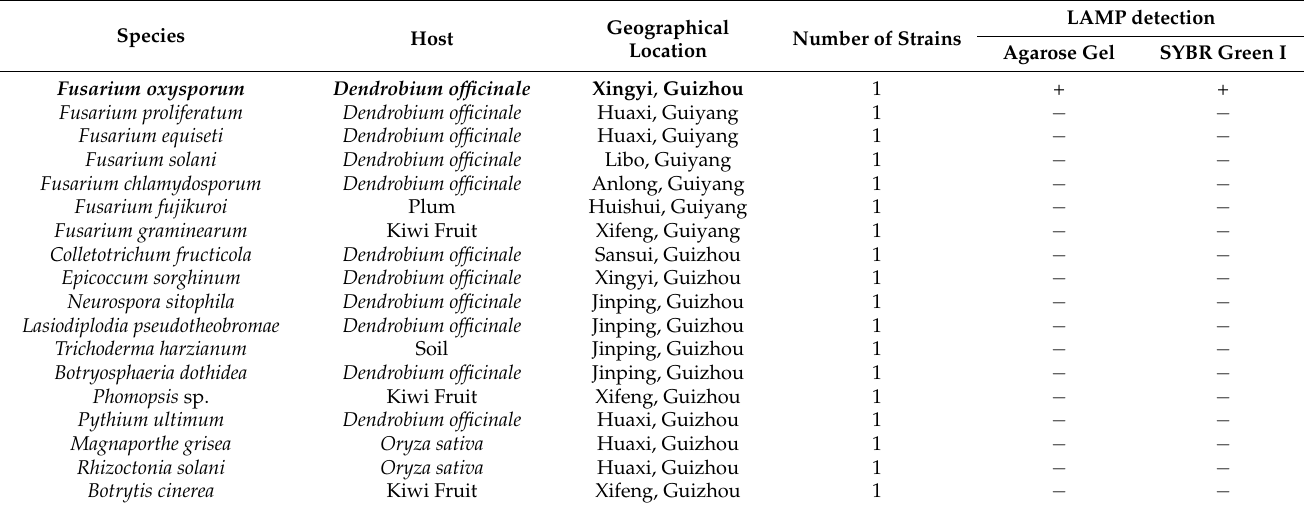
Table 1. Different strains of fungus used in this study to test the specificity of the LAMP assay. Species